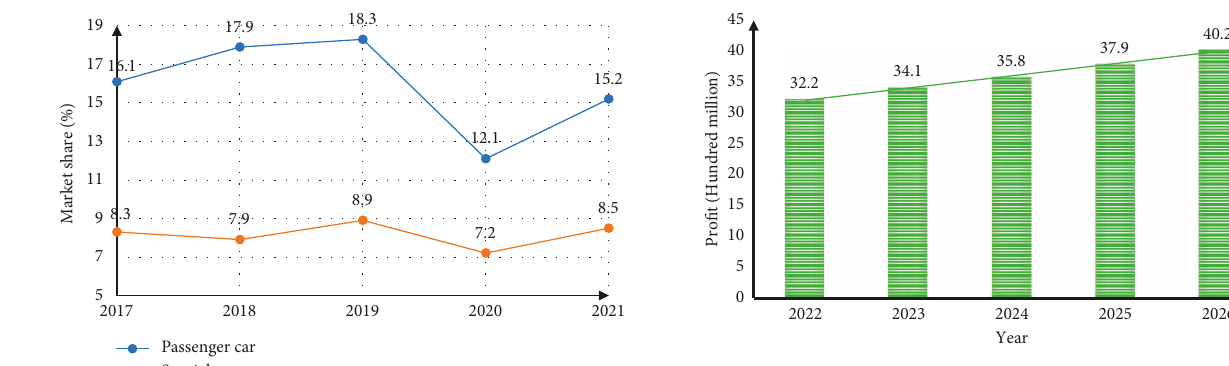
Figure 12: Profit forecast of the enterprise in the next five